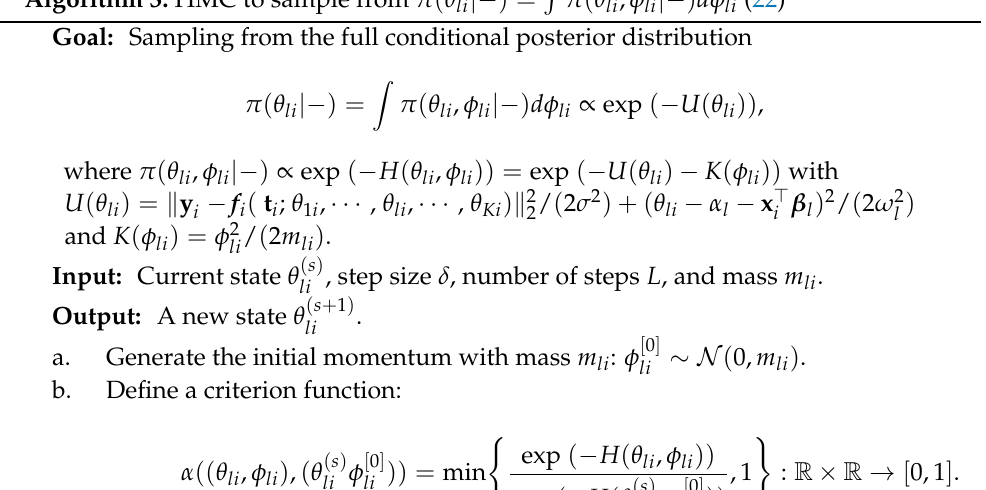
Algorithm 3: HMC to sample from π ( θ li |− ) = Goal: Sampling from the full conditional posterior